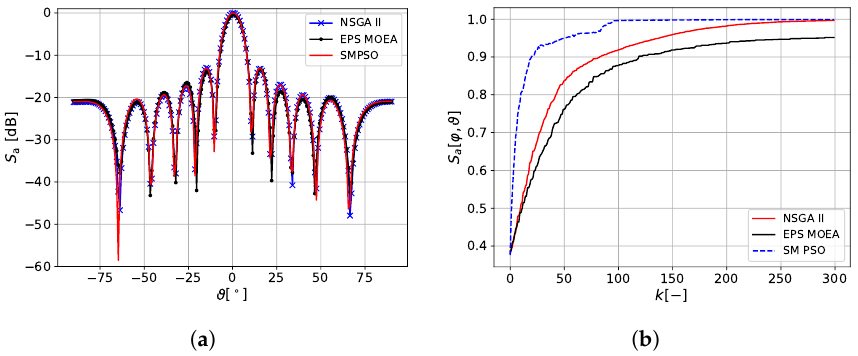
Figure 10. Comparison of algorithms NSGA II, EPS MOEA, and SMPSO. ( a ) Array factor; ( b )